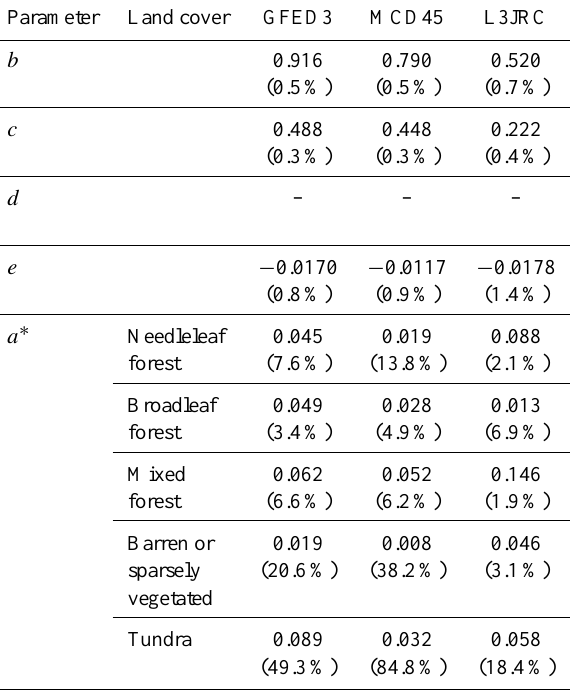
Table A2. Optimal parameters and uncertainties for the case with 32 regions.